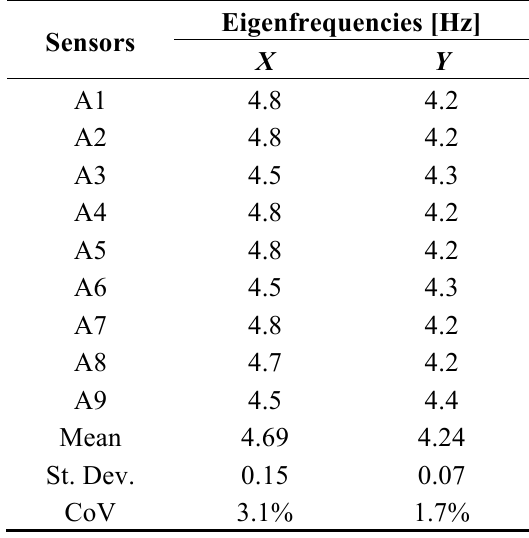
Table 2. Values of frequencies identified by impulsive